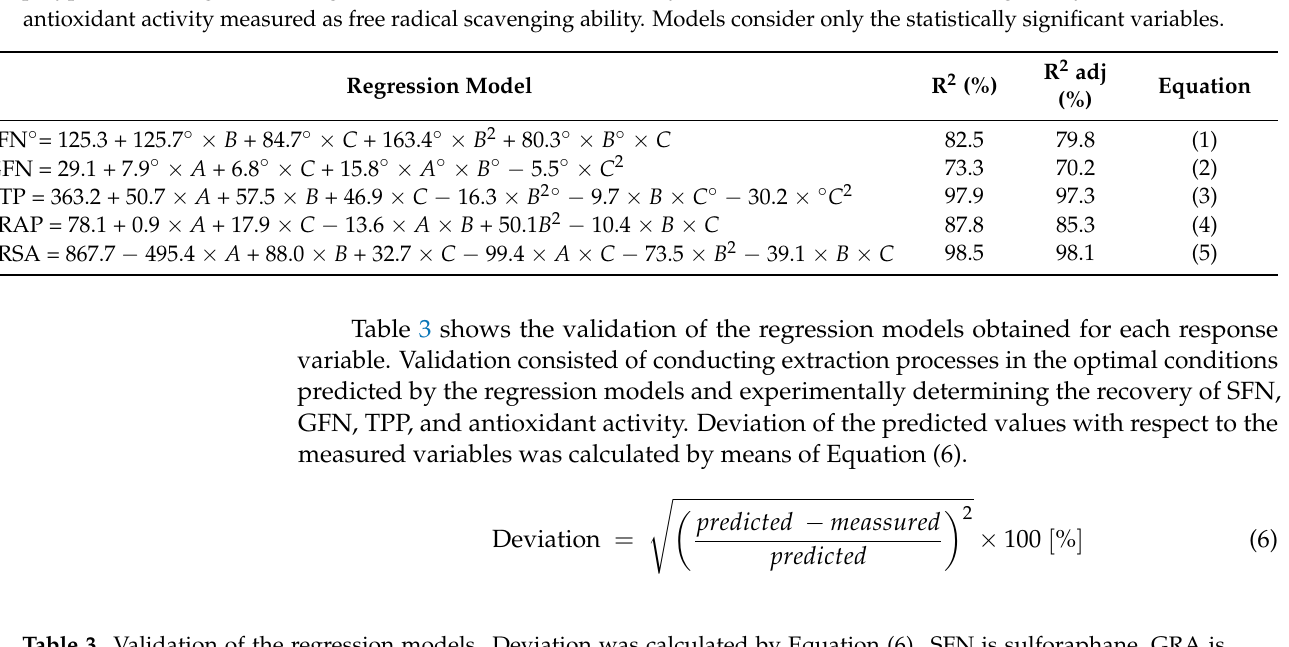
Table 3. Validation of the regression models. Deviation was calculated by Equation (6). SFN is sulforaphane, GRA is glucoraphanin, TPP is total polyphenols, FRAP is antioxidant activity measured as ferric-ion-reducing ability, and FRSA is antioxidant activity measured as free radical scavenging ability. Factor levels are given in real variables, and the coded levels are given in